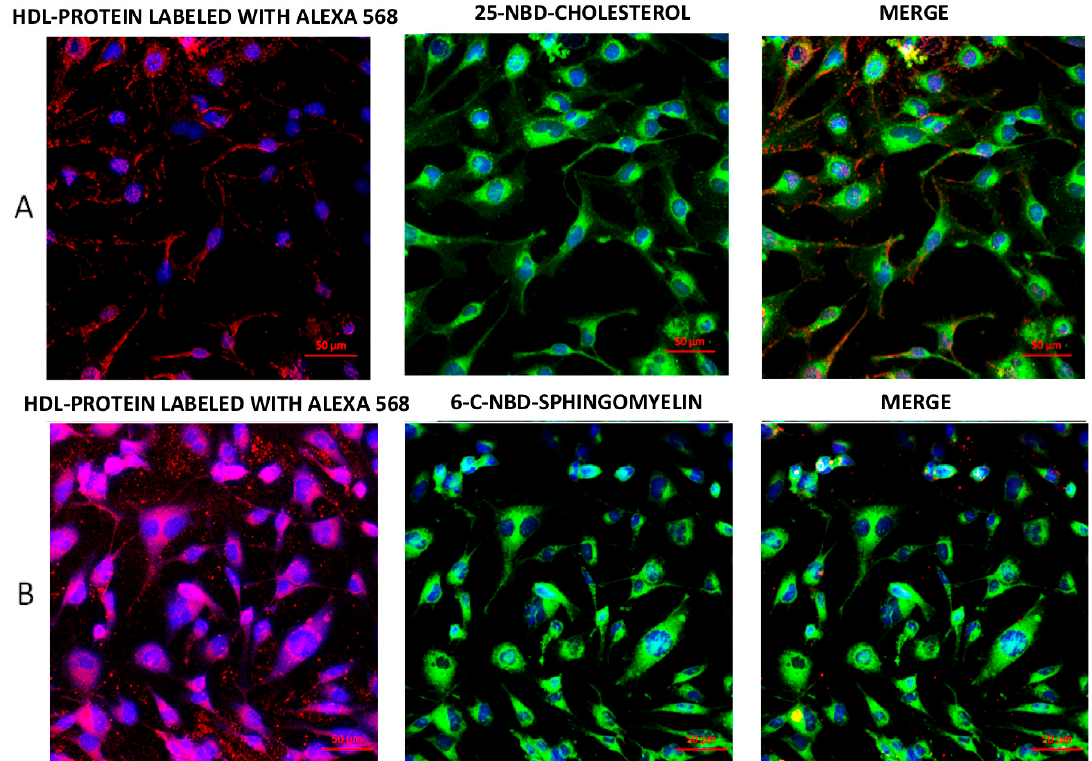
Figure 1. Representative confocal images of lipids and high-density lipoprotein (HDL) protein internalization in HMEC-1 after 20 min incubation with fluorescent double-labeled reconstituted HDL (rHDL). ( A ) Cholesterol and apo AI double-labeled rHDL showed that the cellular location of protein stained with Alexa 568 (red) followed a different distribution when compared with 25-NBD-cholesterol (green). ( B ) Incubation of human dermal microvascular endothelial cells-1 (HMEC-1) with rHDL containing C-6-NBD-sphingomyelin and HDL protein labeled with Alexa 568 fluorescent tracers. Both sphingomyelin and protein colocalized within the cells. Nuclei were labeled with 4 ′ ,6-diamidino-2-phenylindole (DAPI) (blue). Scale bars represent 50 μ m.